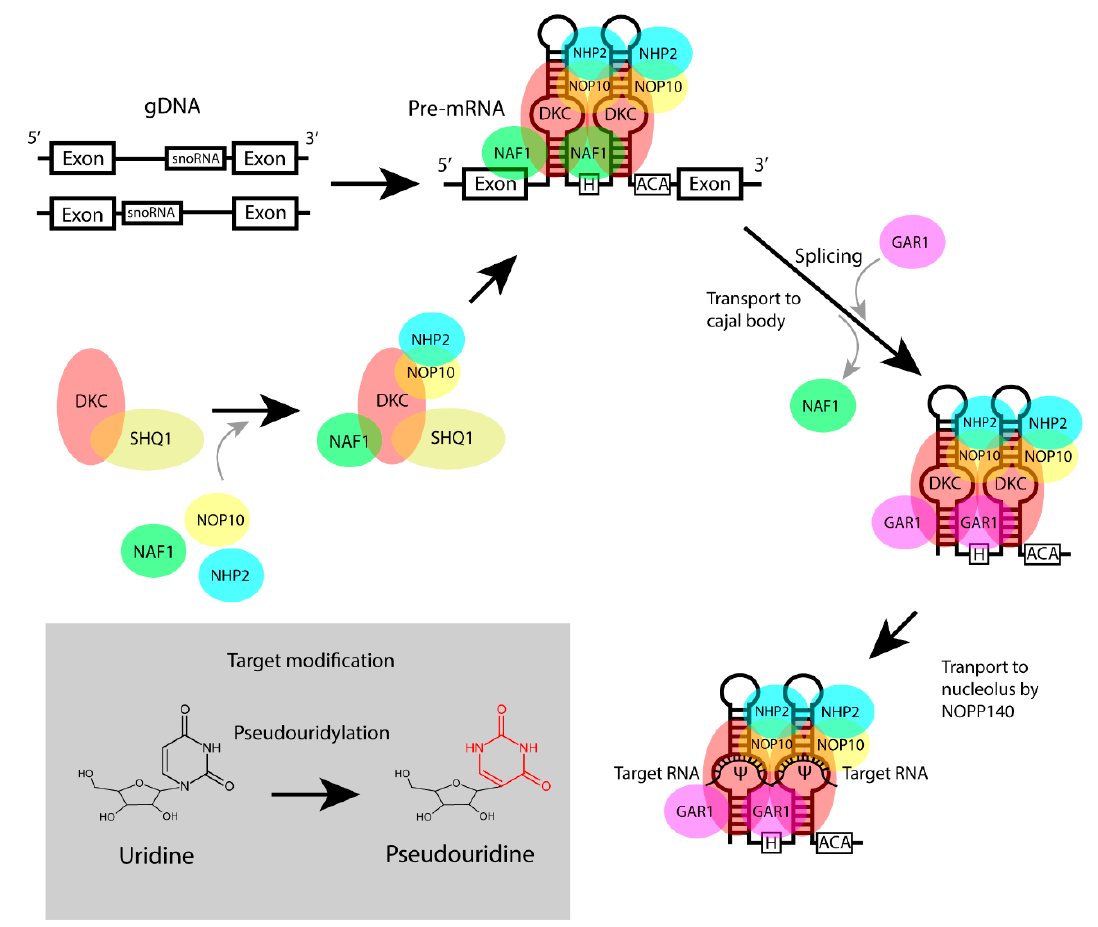
Figure 2. Biogenesis of H/ACA box snoRNP. The generation of a H/ACA box snoRNP complex starts with the binding of the SHQ1 protein to dyskerin (DKC1). Subsequently, three additional proteins (nuclear assembly factor 1 (NAF1), H/ACA RNP complex subunit 3/nucleolar protein 10 (NOP10) and H/ACA ribonucleoprotein complex subunit 2 (NHP2)) bind the DKC1-SHQ1 complex, mediated by the RUVBL1-RUVBL2-TAH1-PIH1 (R2TP) complex [20,35]. After the release of SHQ1, this new complex is then transported to the nucleus where it binds the snoRNA sequence on the pre-mRNA. After splicing, the immature H/ACA box snoRNP is translocated to the Cajal bodies where NAF1 is exchanged by H/ACA ribonucleoprotein complex subunit 1 (GAR1). The H/ACA box snoRNP is translocated to the nucleolus by NOPP140, where it can perform the pseudouridylation of target rRNA. Figure modified from reference [35].